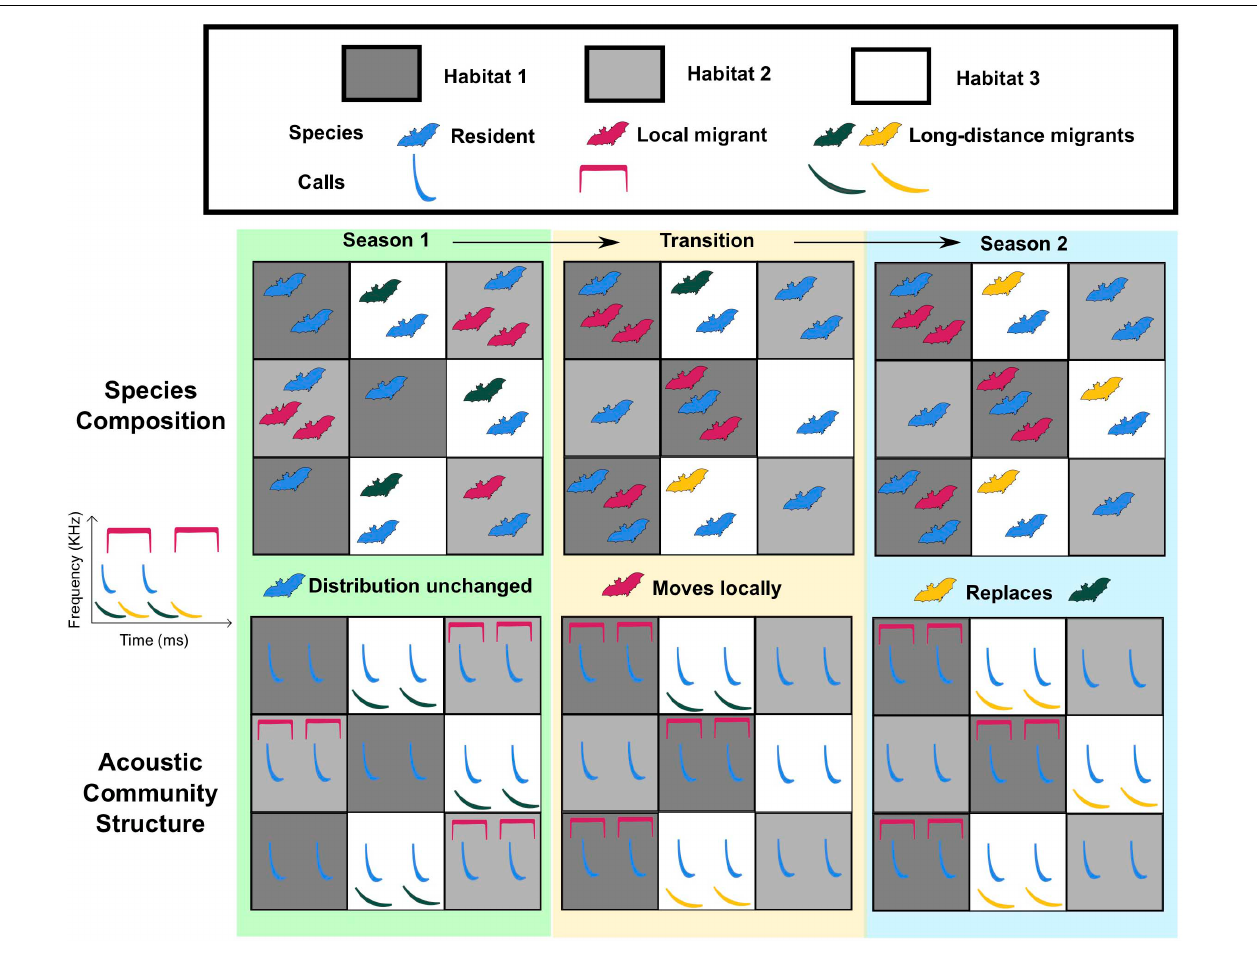
FIGURE 3 | Ecological changes are reflected in the acoustic community. Spatiotemporal change in a hypothetical bat acoustic community (consisting of resident and migrant species). Each habitat within this landscape is represented by a square, with colors representing different habitat types. Each bat species calls at a distinct frequency (see key on the left), and species composition in each cell changes with seasonal transitions (top row). Recorders placed in each square are predicted to detect spatiotemporal changes in acoustic community structure (bottom row), serving as a framework for long-term monitoring. Similar changes may also occur due to hibernation or seasonal differences in signaling